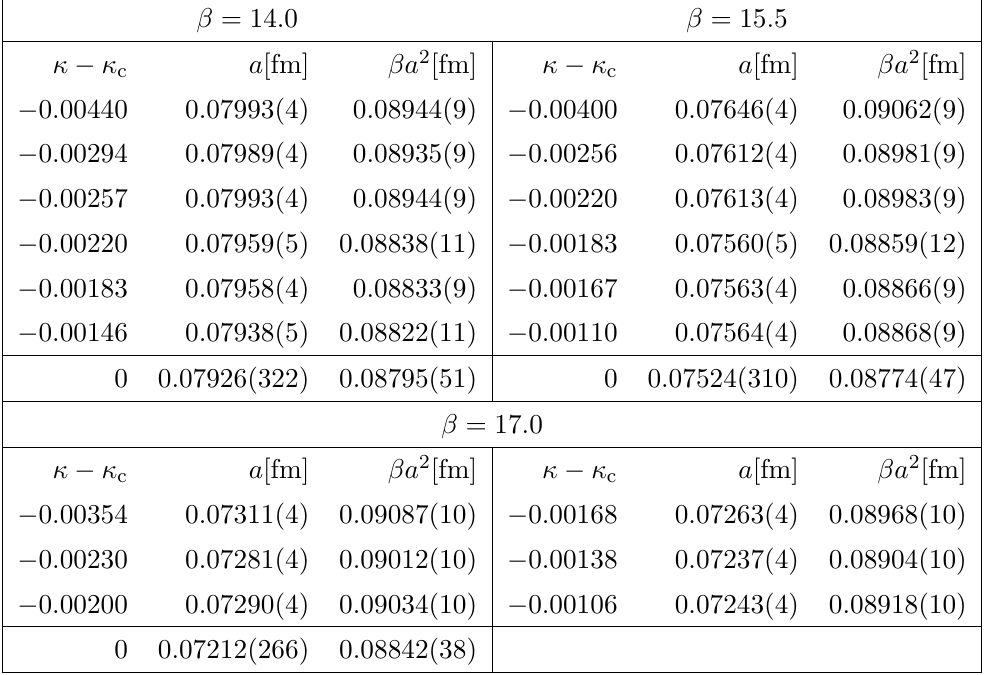
Table 5. Lattice spacing for di(cid:11)erent combinations of (cid:12) and m f . In the last rows of each (cid:12) section we give the extrapolations to the chiral